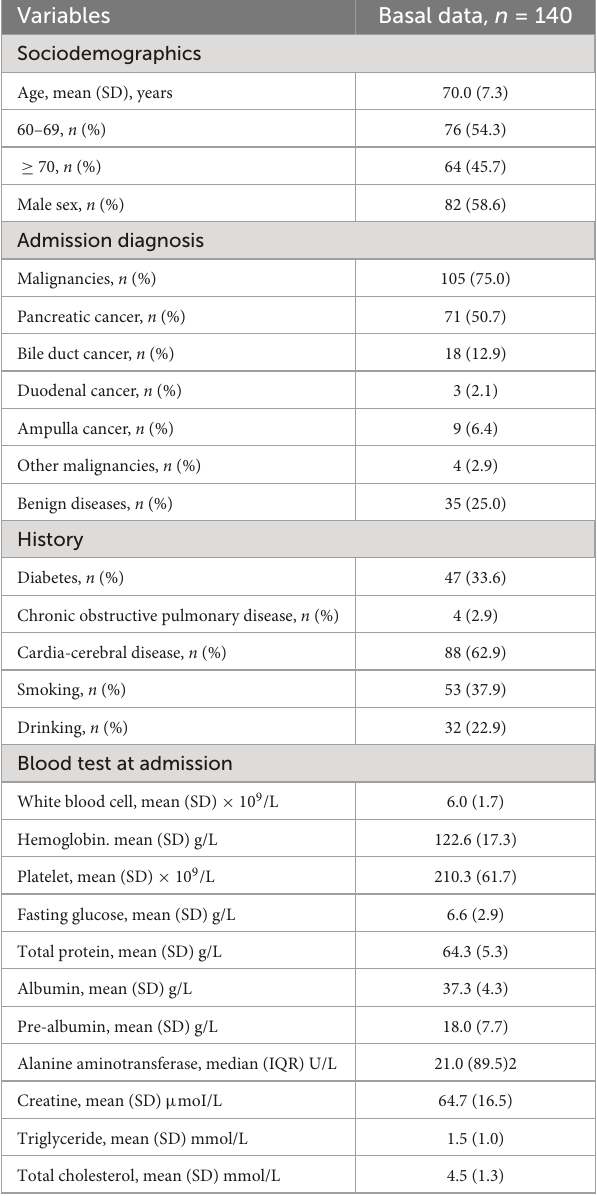
TABLE 2 Baseline